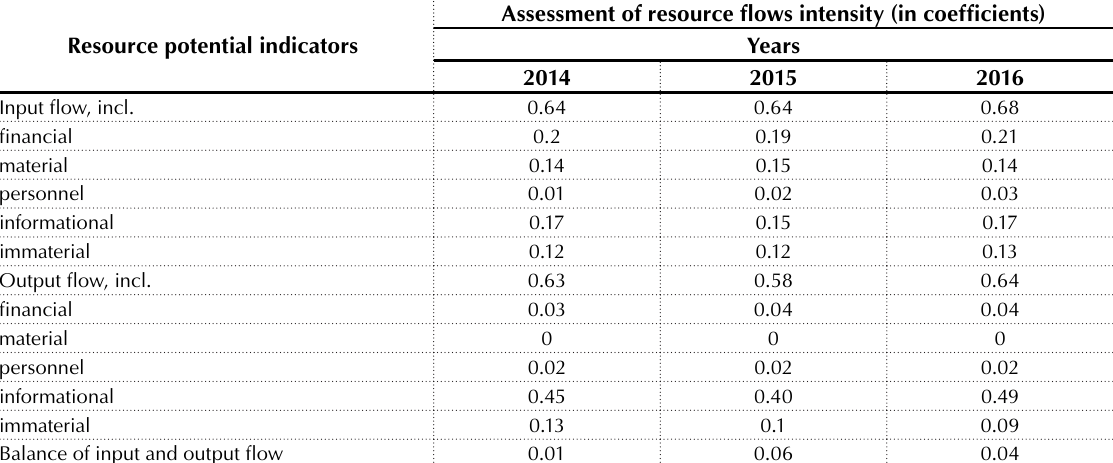
Table 2. Indicators of the intensity of tourism enterprise interaction within the framework of participation in the tourism cluster “Gogol’s places”, Poltava region Resource potential indicators